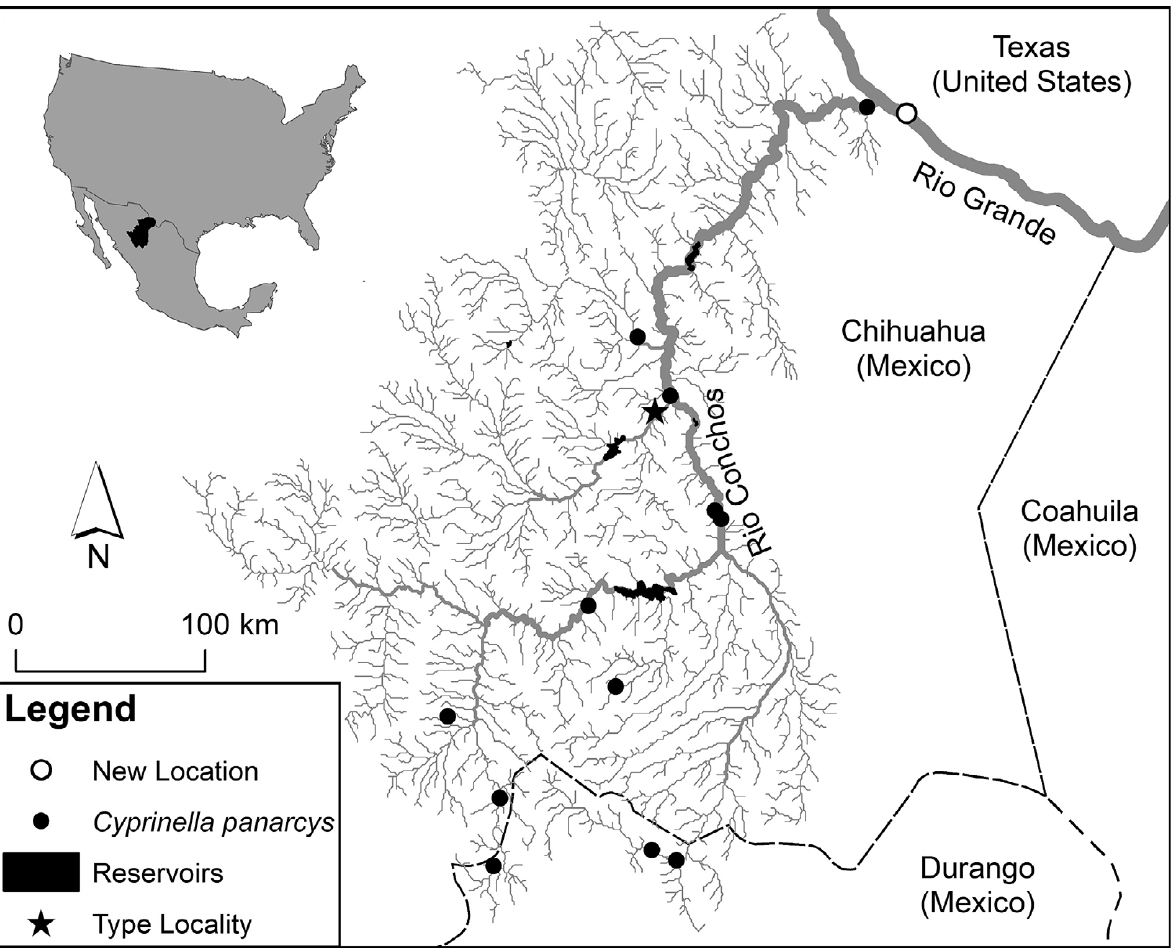
Figure 2. Known localities of Cyprinella panarcys based on museum vouchered material in collections located in the USA and from the litera- ture (Contreras-Balderas and de Lourdes Lozano 1994). Type locality identified by a black star. New USA locality indicated by an open